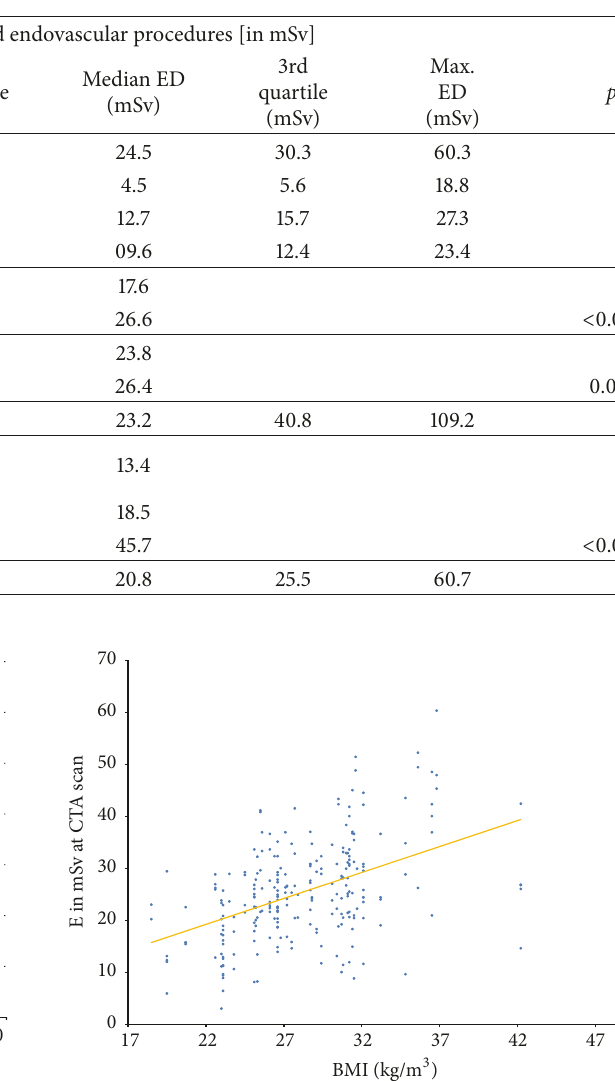
Table 2: Effective doses from CTA and interventional procedures [in mSv].